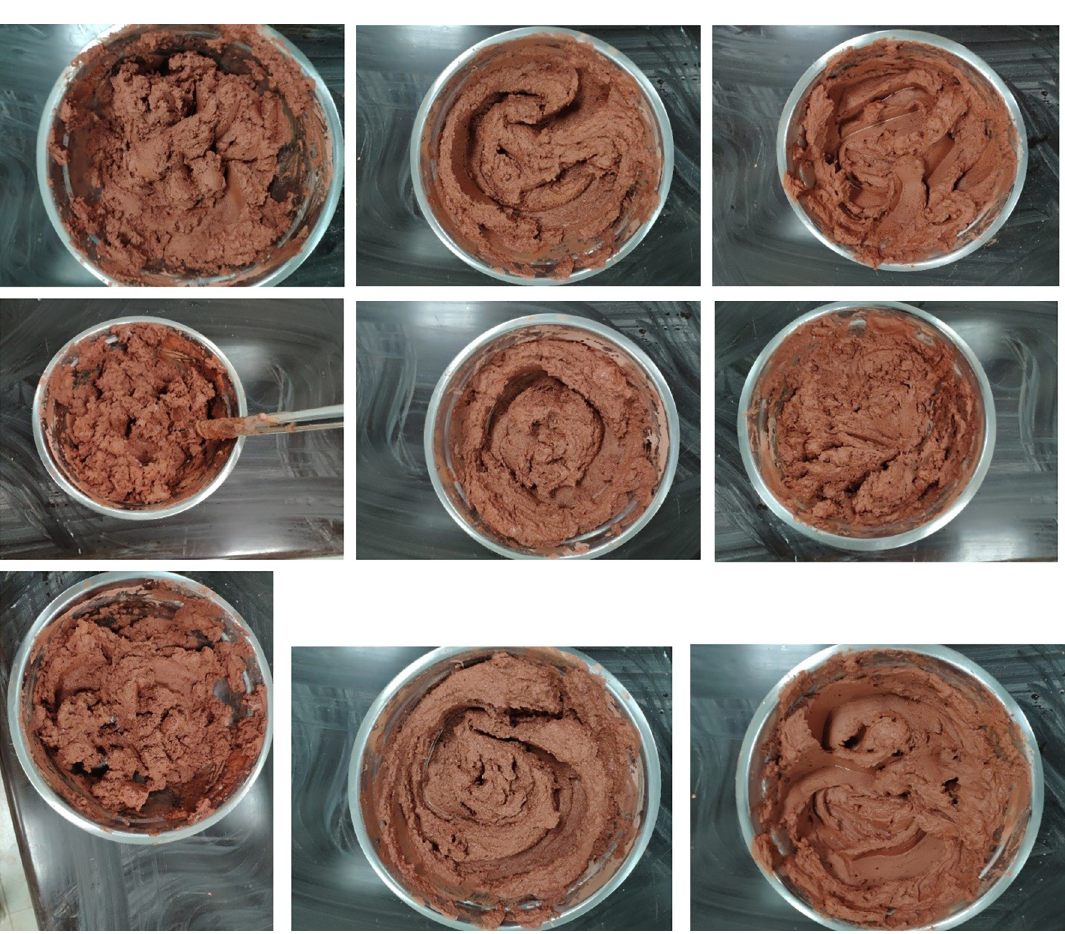
Fig 6. Nine naturally weathered red-bed soil slurry samples (A) No. 1; (B) No. 2; (C) No. 3; (D) No. 4; (E) No. 5; (F) No. 6 (G) No. 7; (H) No. 8; (I) No. 9.